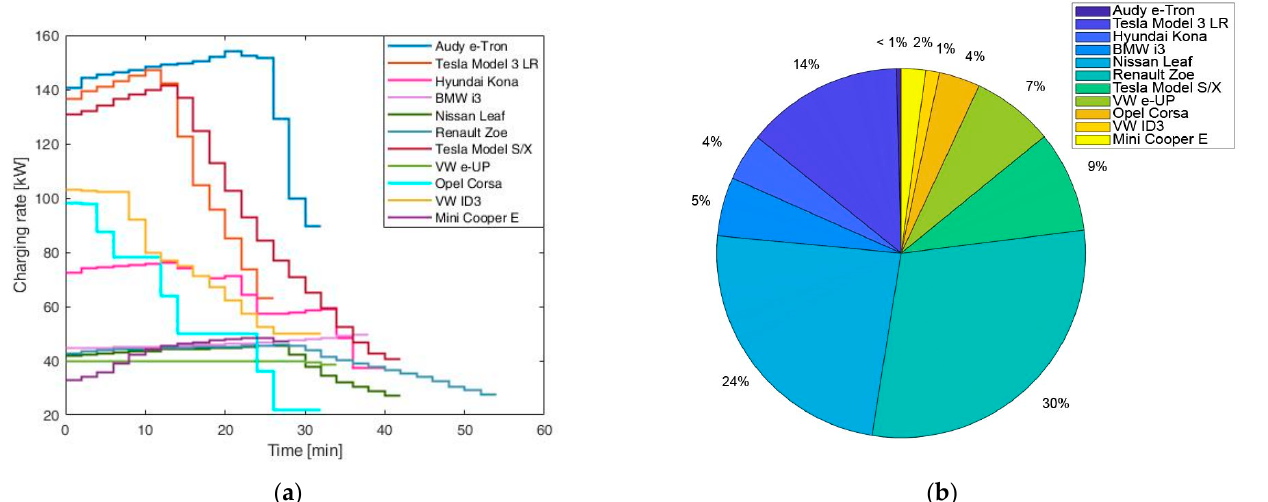
Figure 10. Electric vehicles: ( a ) discretized charging curves; ( b ) probability.